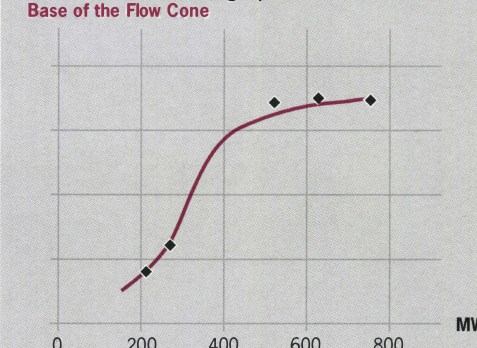
Fig.l: Effects of anionic dispersion agents